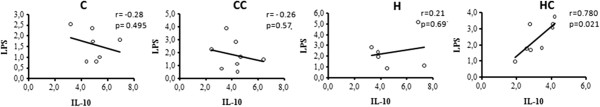
Correlation between LPS and IL-10 in liver (n = 6-8).